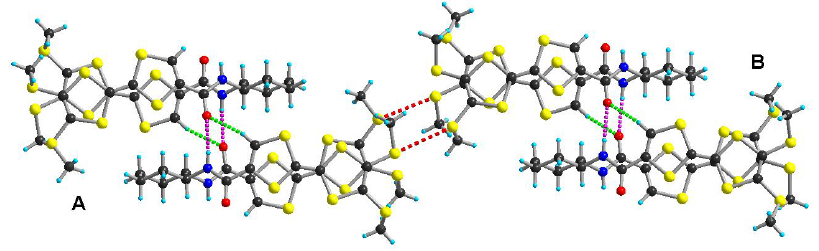
Figure 7. H bonding interaction between A - and B -type molecules.